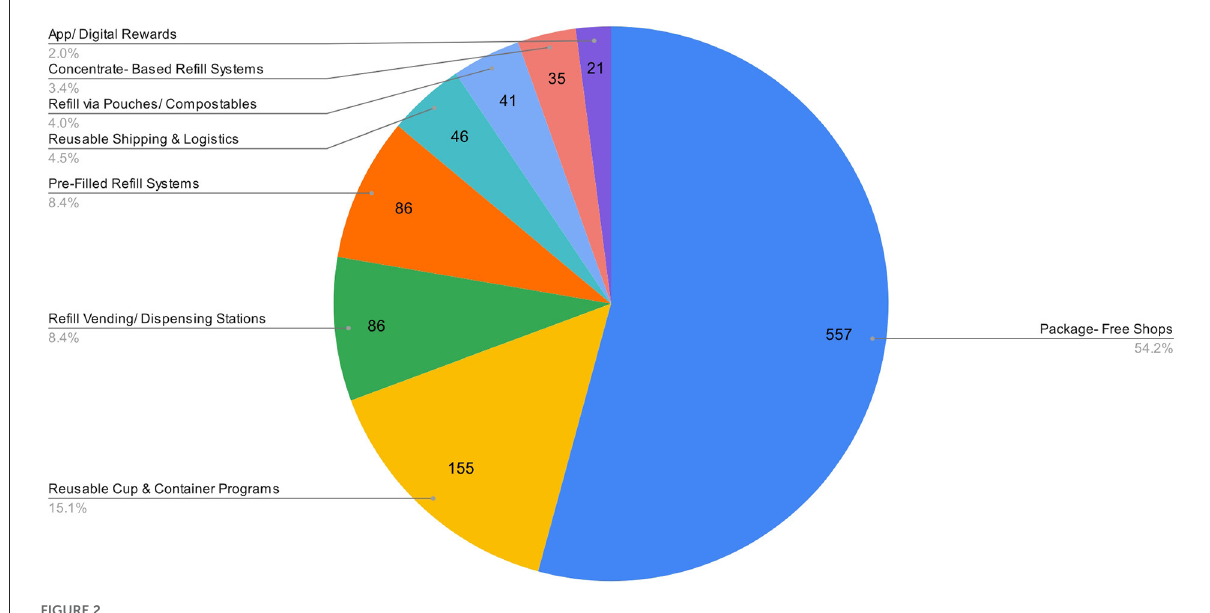
FIGURE2 Reuse and refill solutions by category.